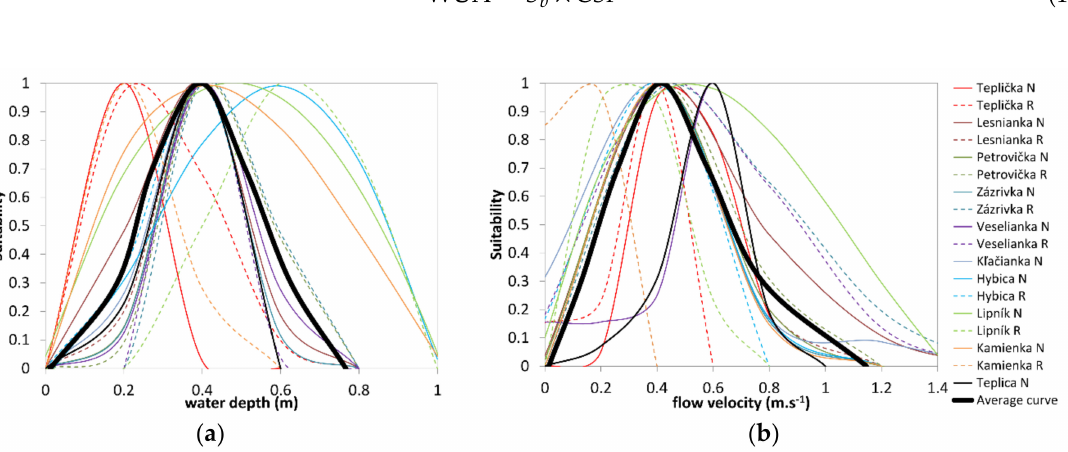
Figure 2. Suitability curves for ( a ) water depth and ( b ) flow velocity on the mountain streams of Slovakia. Natural streams (N) are represented by solid lines, and regulated streams (R) are indicated by dashed lines. The average suitability curve is shown by a thick, black line—adapted from